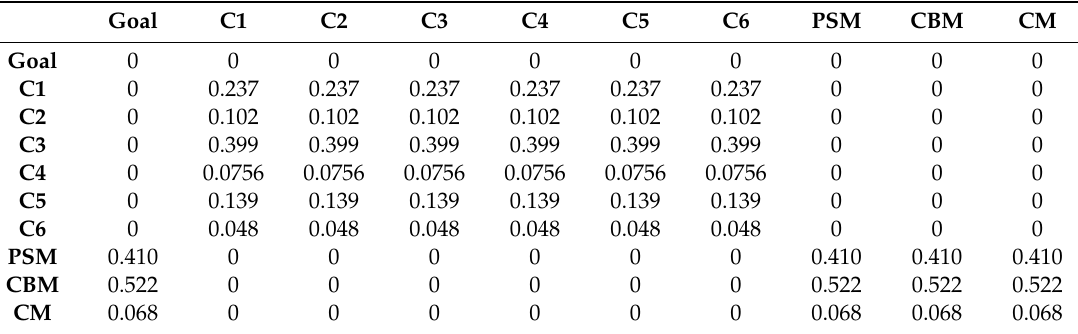
Table 6. The final weights of limit supermatrix W L